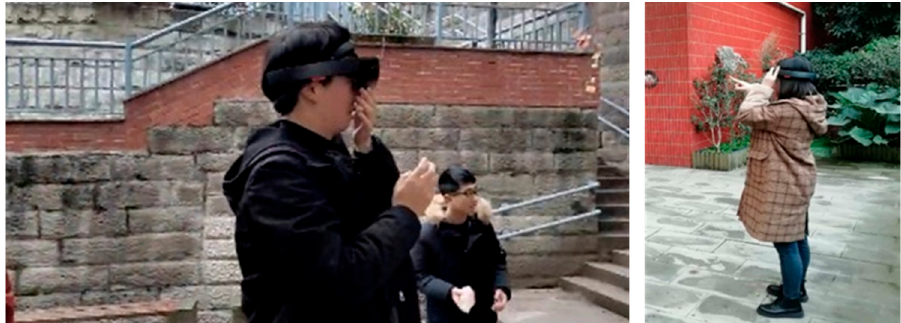
Figure 6. Participants engaged in the on-site design experience.